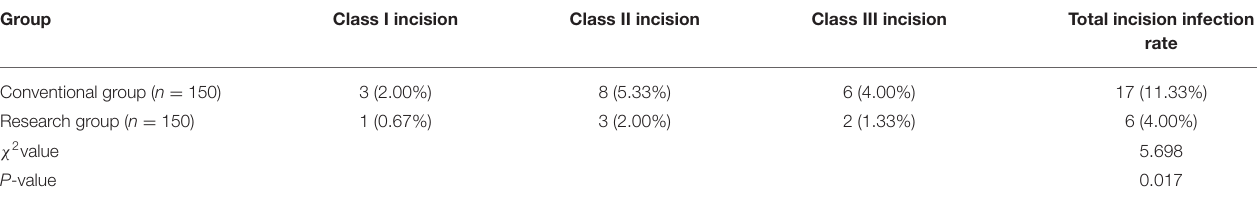
TABLE 3 | Incidence of surgical incision infection in the two groups ( n , %).